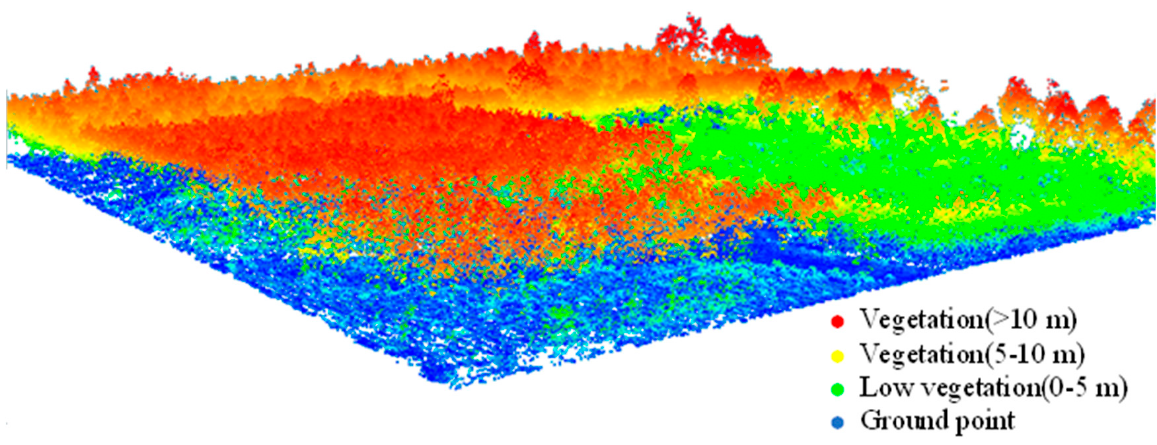
Figure 2. Elevation normalized point cloud of the study area.